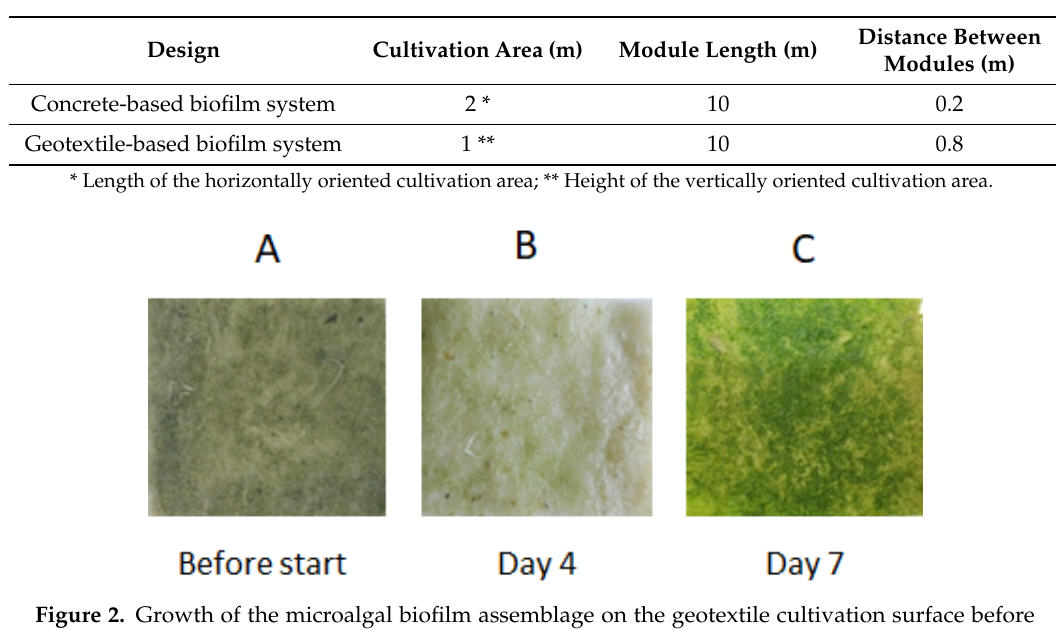
Table 2. Design parameters of microalgal biofilm modules for a large-scale WWT P removal system.